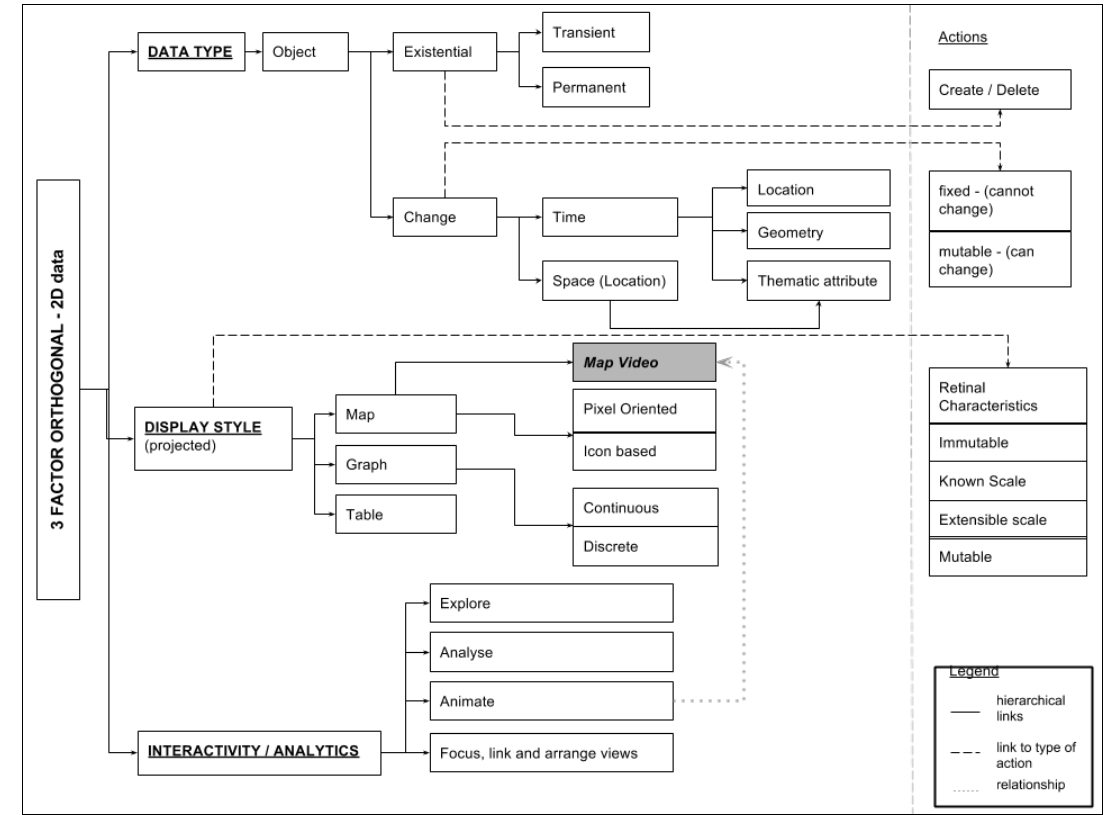
Figure 3. Visualisation library taxonomy for 2D streaming data